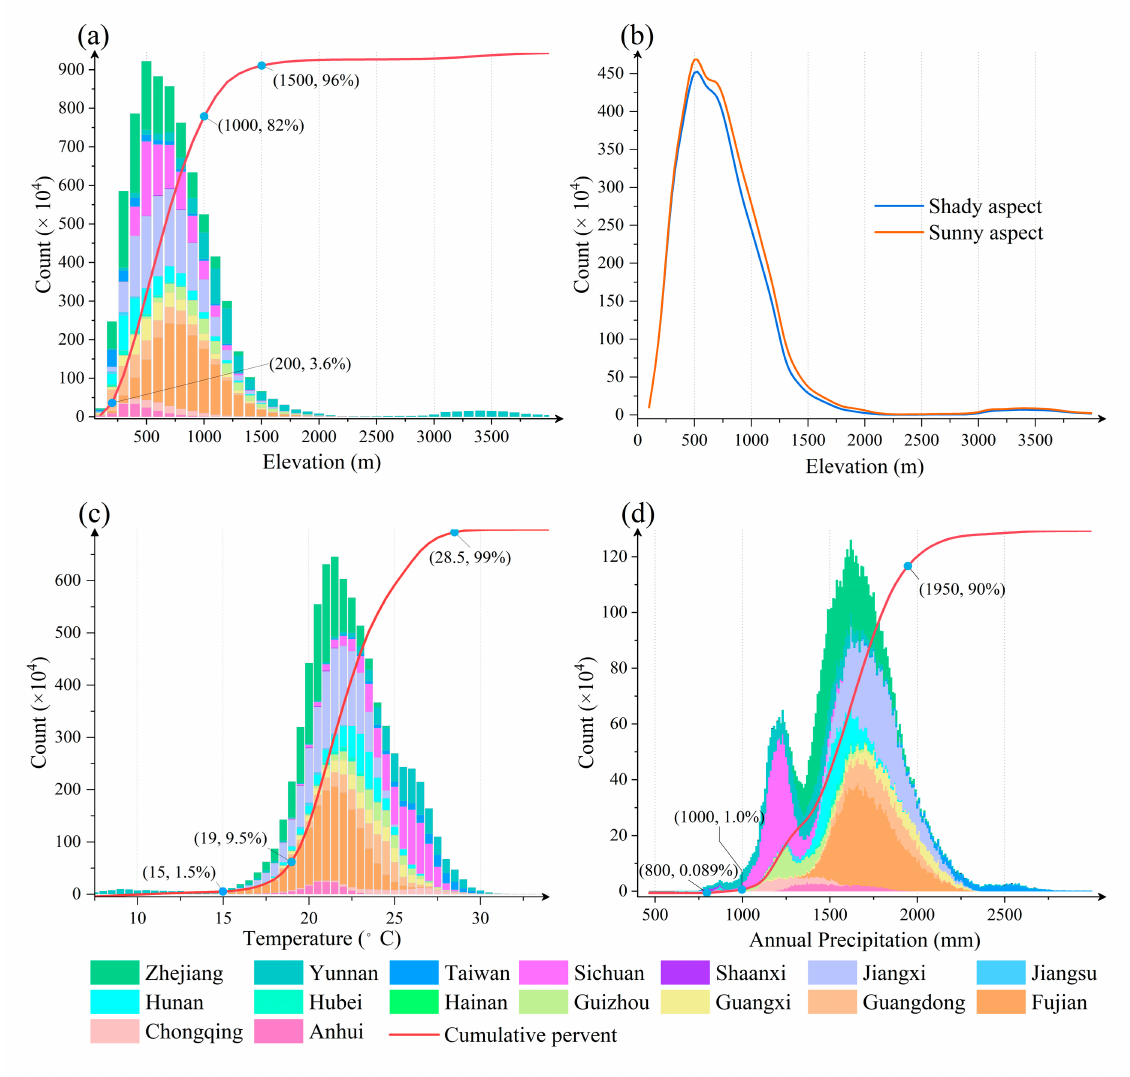
Figure 7. Spatial patterns of elevation ( a ), aspect ( b ), temperature ( c ), and annual precipitation ( d ) of bamboo forests in